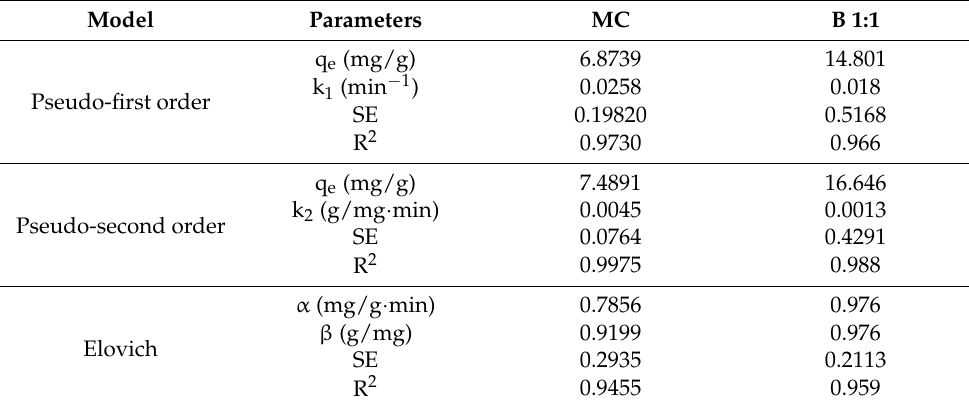
Table 5. Adjustment parameters of sulfate adsorption